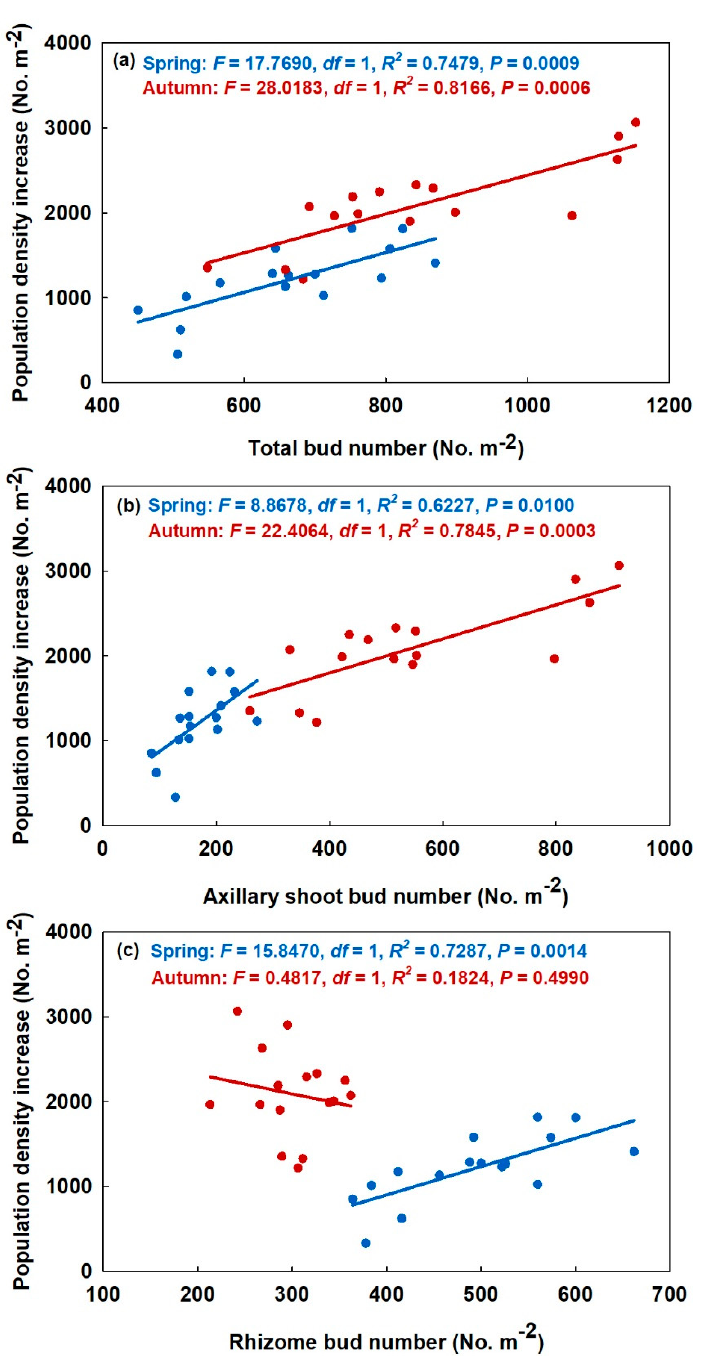
Figure 5. The linear regression analysis of total bud number ( a ), axillary shoot bud number ( b ) and rhizome bud number ( c ) to population density increase. The same color denotes the same season.